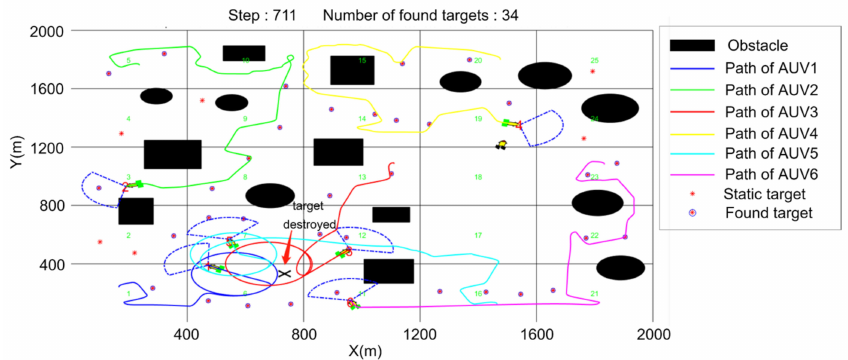
Figure 22. T = 711